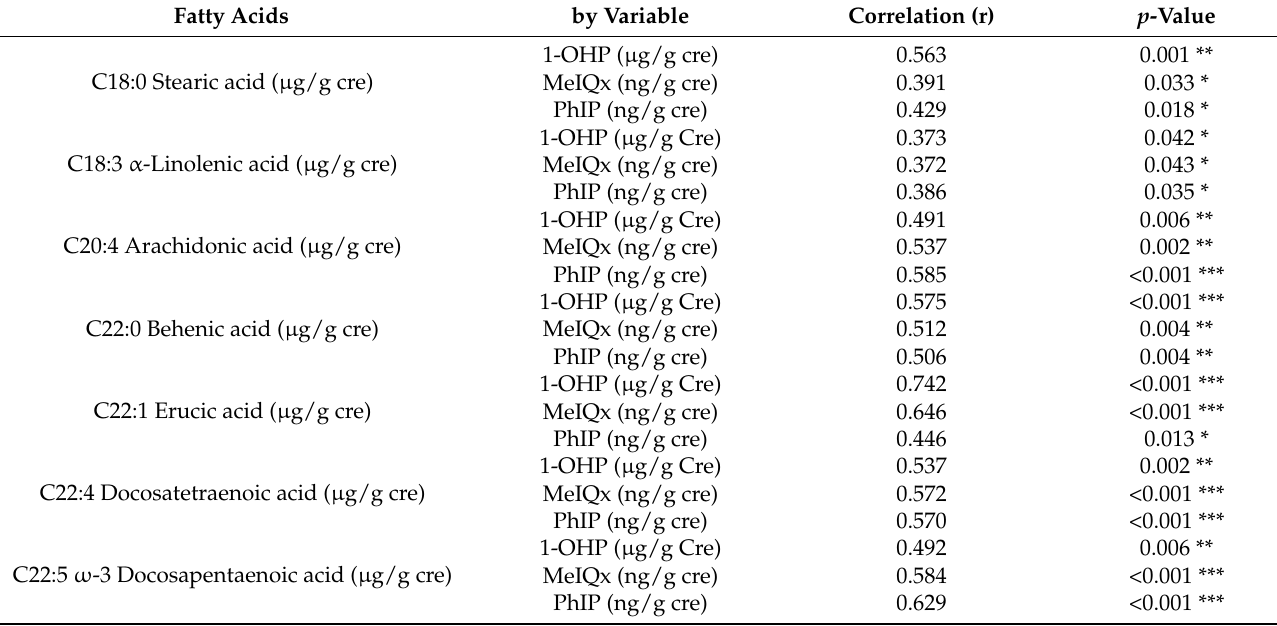
Table 4. Exposure biomarkers-associated fatty acids.